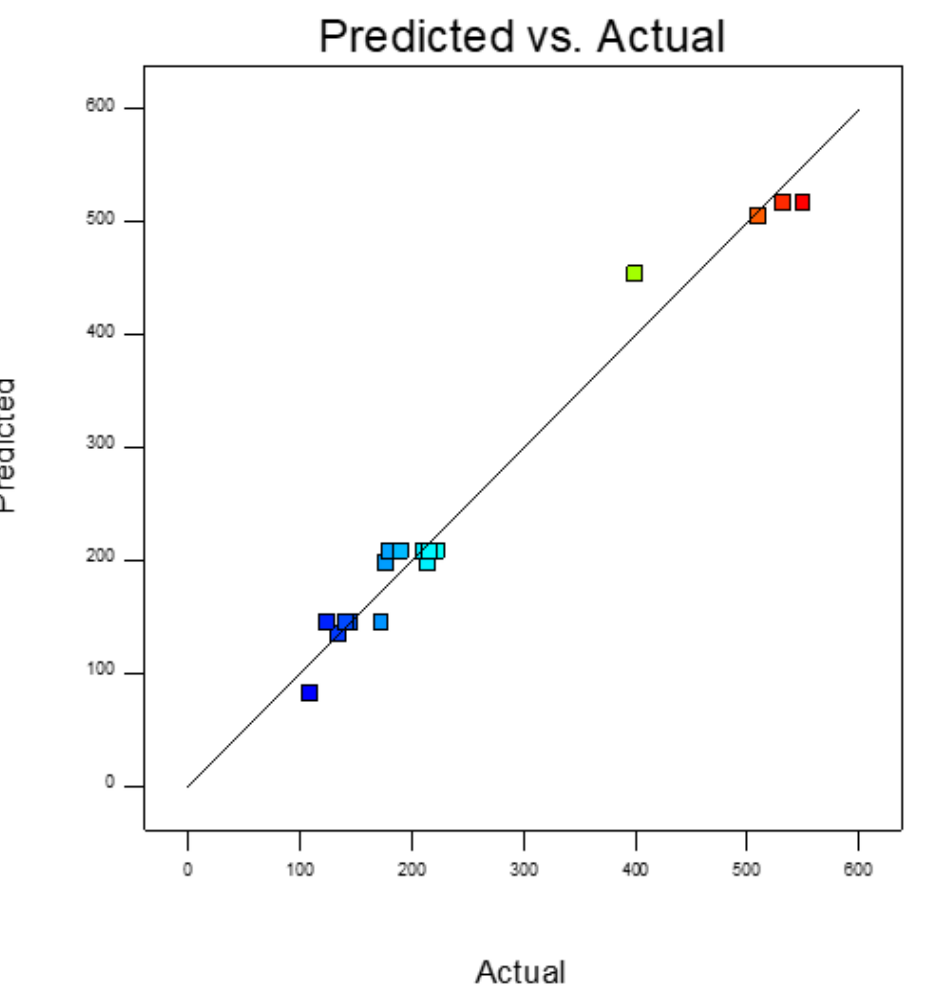
Figure 7. Scatter diagram biogas generation (ml/g VS) for AD of pot ale.